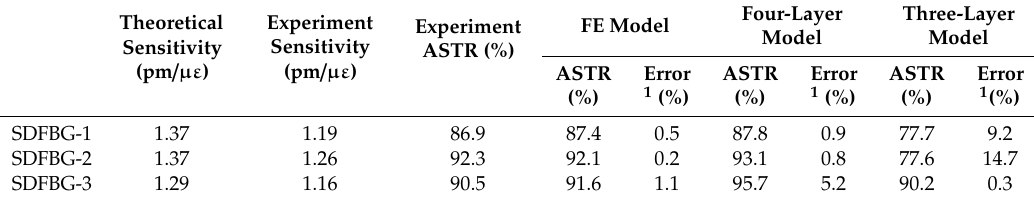
Table 5. Theoretical and experiment results for strain-transfer